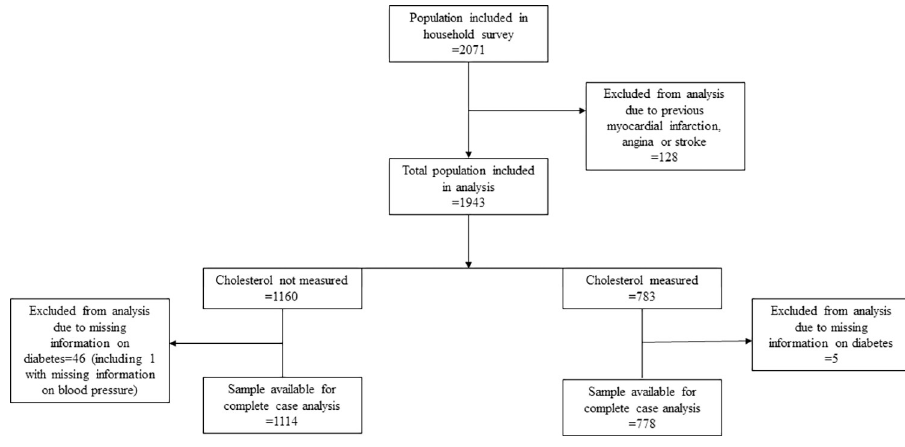
Fig 1. Flow diagram of individuals included in the